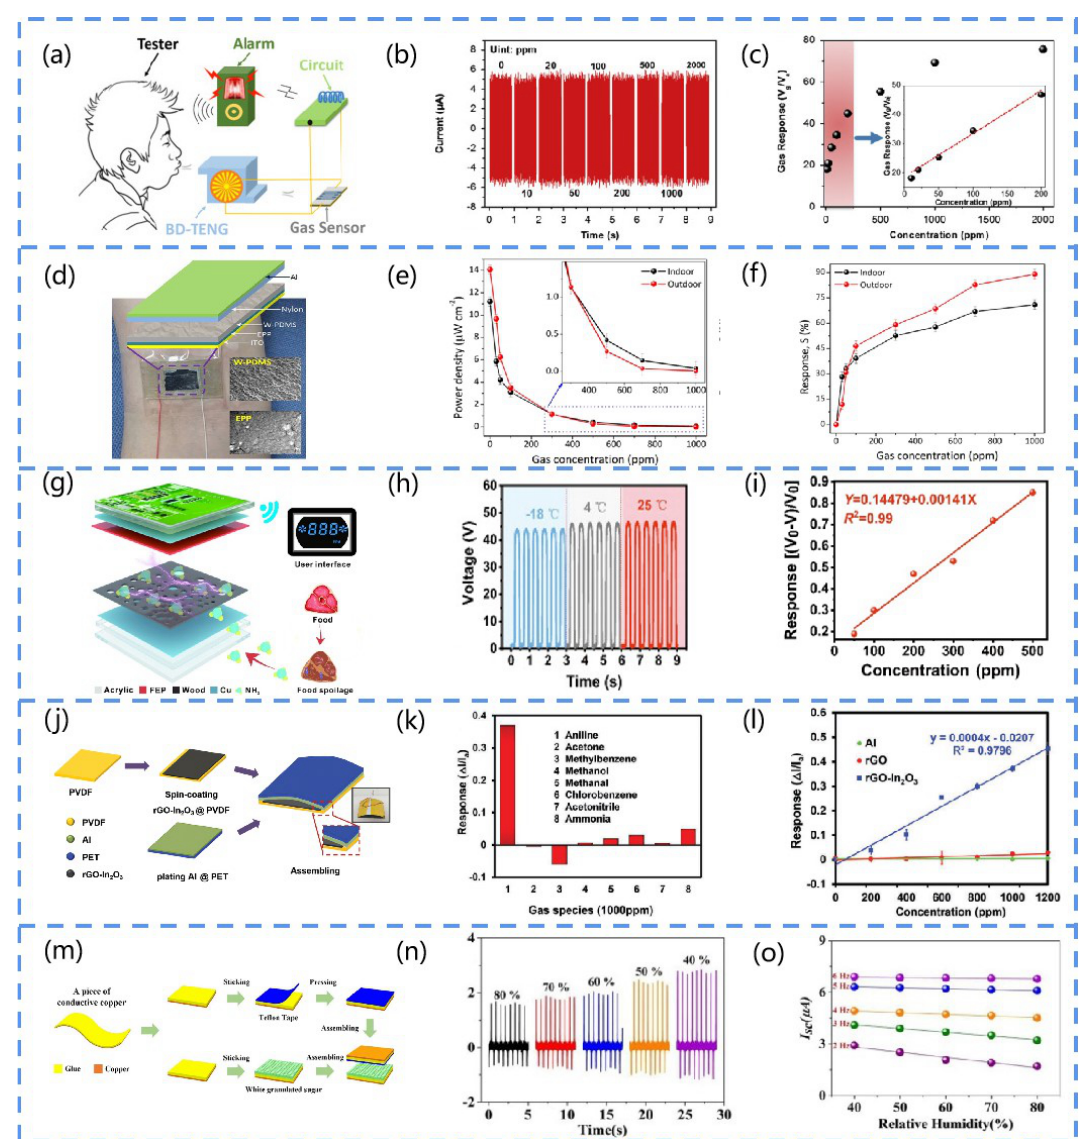
Figure 14. ( a ) Schematic diagram of the TENG as an active alcohol sensor. ( b ) Output current of the device under alcohol (concentration from 10 to 2000 ppm). ( c ) Plot of output voltage versus alcohol. Reprinted from [103] with permission from Elsevier. ( d ) Schematic diagram of the TENG device. ( e ) Plot of power density versus C 2 H 2 concentration. ( f ) Response of the device to different concentrations of C 2 H 2 concentration. Reprinted from [104] with permission from ACS Publications. ( g ) Schematic diagram of the TWGSS device. ( h ) Open-circuit voltage of the TENG at different temperatures. ( i ) Response of the TENG to different concentrations of ammonia gas. Reprinted from [105] with permission from Elsevier. ( j ) Schematic diagram of the fabrication process of rGO- In 2 O 3 -TENG films. ( k ) Open-circuit voltage of the TENG monitoring gas. ( l ) The concentration response of the TENG to the gas. Reprinted from [106] with permission from Wiley Online